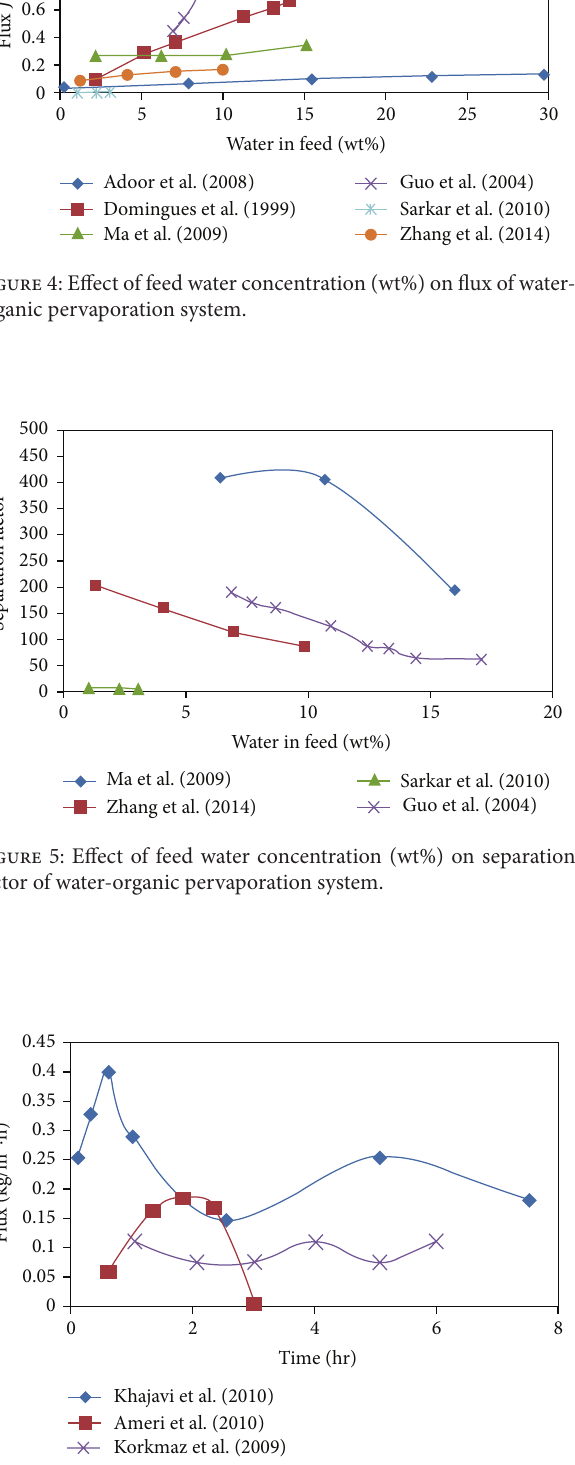
Figure 6: Obtained trend of flux with time for different pervapora- tion